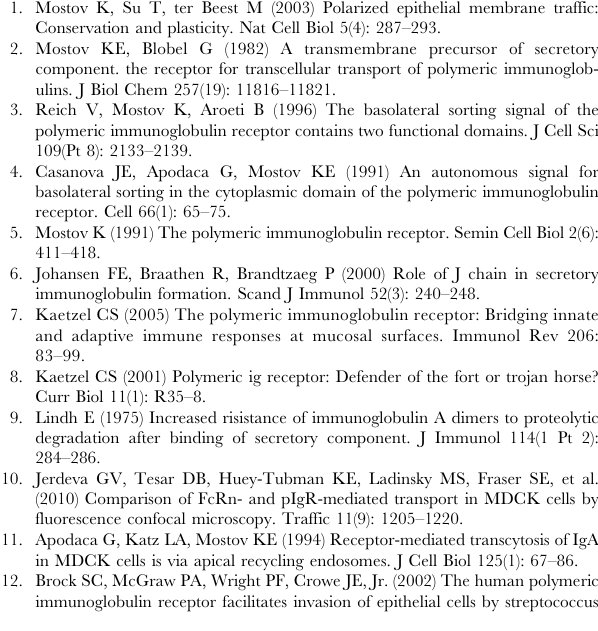
Figure S1 Colocalization study of internalized VHH 4b7 with endosomal marker EEA1. 1 m M VHH was applied either apically for 1 h or basolaterally for 20 min. Cells were fixed and immunolabelled with R- a -VHH (Alexa-555) and M- a -EEA1 (Alexa-488) and stained with DAPI. Figure S2 Epitope mapping of VHHs. 30 nM of myc-VHH is incubated with indicated amounts of flag-VHH in an hpIgR coated well for 2 h at room temperature. Myc tag presence is subsequently quantified and plotted against the concentration of flag-VHH (n=